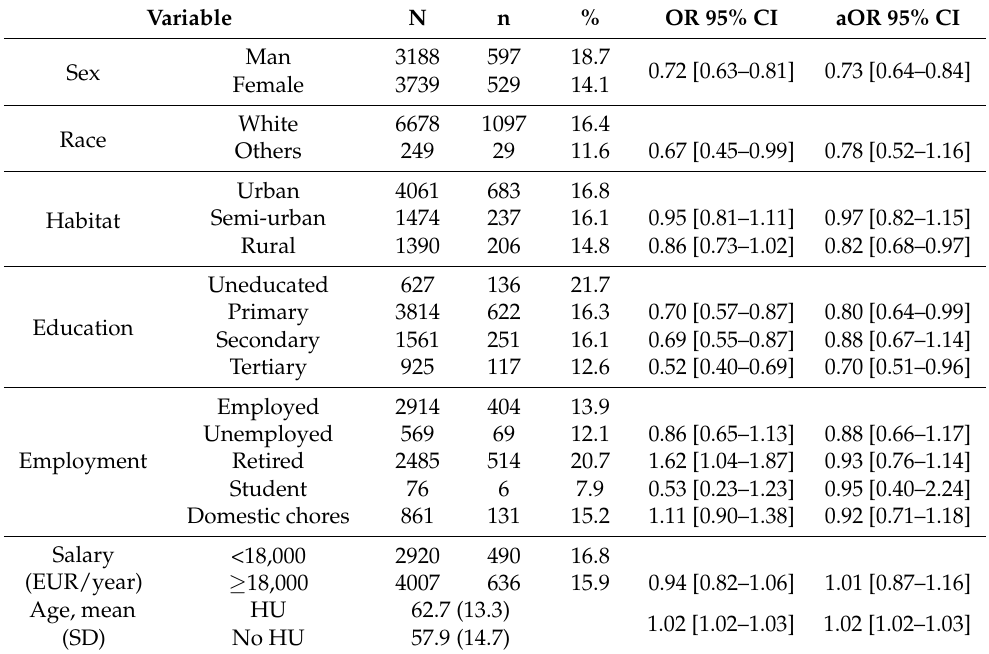
Table 1. Distribution in the prevalence of hyperuricemia according to various socio-demographic variables.